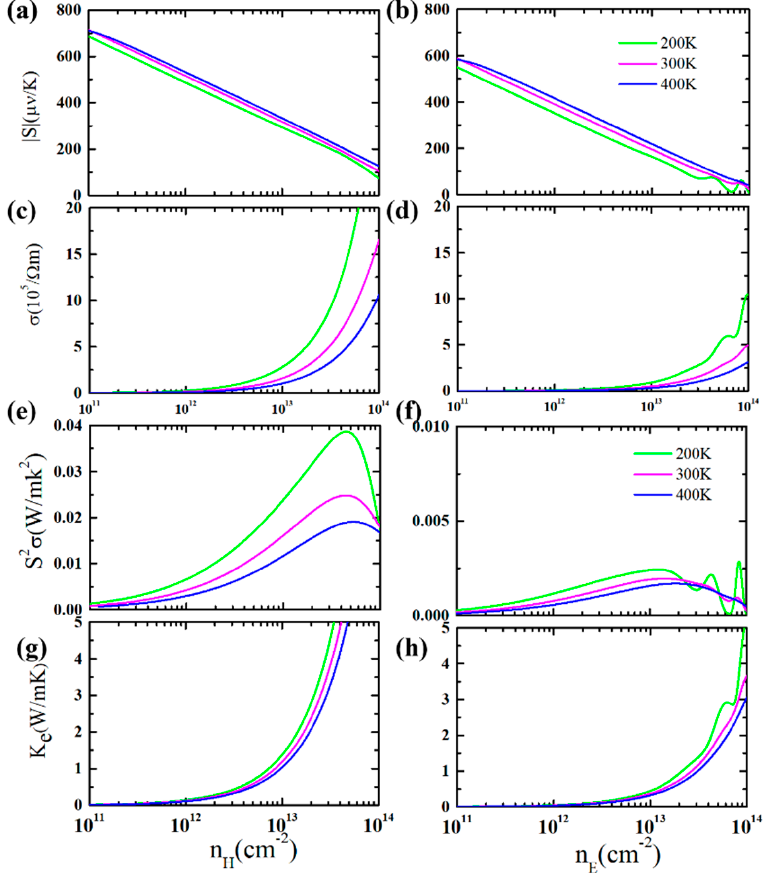
Figure 2. The absolute value of Seebeck coefficient ( a , b ), the electrical conductivity ( c , d ), the power factor ( e , f ), and the electronic thermal conductivity ( g , h ) with the change of carrier concentration and temperature for monolayer GeP 3 . The left (right) part represents the p -type ( n -type) doping. After attaining the electronic transport properties of the GeP 3 monolayer, we now examine the phonon transport property. The obtained phonon band structure and phonon density of states of GeP 3 monolayer are presented in Figure 3a. No imaginary phonon frequency appears which implies the stability of monolayer GeP 3 . The lowest three phonon modes at the Γ point are acoustic phonon branches, i.e., the in-plane transverse acoustic branch (TA), the z -direction acoustic mode (ZA), and the in-plane longitudinal acoustic branch (LA). The maximum frequency of acoustic branches is only 1.81 THz, which is comparable or lower than those of admirable TE materials, such as PbTe and SnSe [39], indicating a smaller phonon group velocity in monolayer GeP 3 . In addition, the flat phonon dispersion characteristics of acoustic branches closed to the Γ point is also a key to obtaining a small phonon group velocity and a low lattice thermal conductivity. As expected, the group velocities that could be computed by ∂ ω / ∂ k are 1.70, 1.27 and 1.63 kms − 1